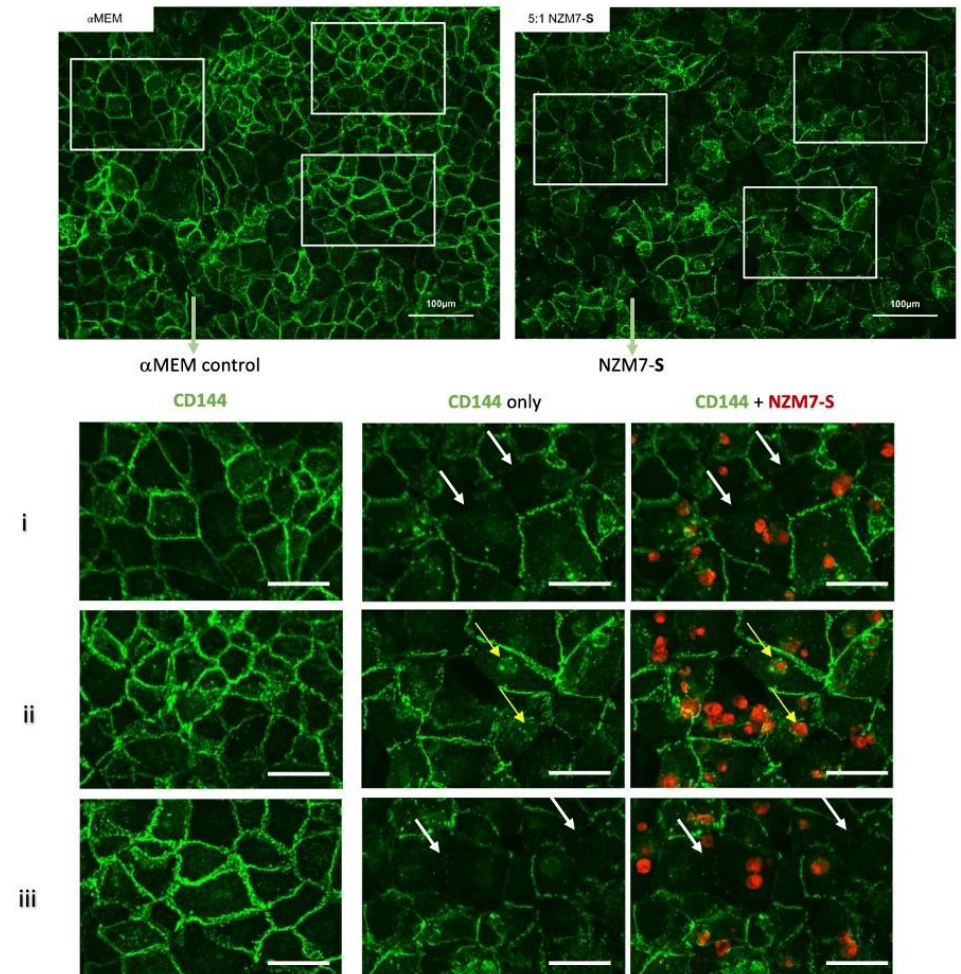
Figure 7. Expression of CD144 following the addition of 100,000 NZM7-S events to human cerebral microvascular endothelial cells. hCMVECs were seeded at 20,000 cells per well. After 48 h NZM7-S (red) was added in α MEM media and co-cultured for 4 h. Panels i – iii show expanded sections of the white boxes. Single left panel in i –iii shows αMEM control, and the two right panels show melanoma treated images. White arrows indicate lack of CD144 on cell borders. Yellow arrows indicate cytoplasmic expression of CD144 underneath NZM7-S. Images were acquired on the Operetta CLS imaging system. Full view images scale bar = 100 µm, cropped images scale bar = 50 µm. Images are representative of 2 independent experiments.